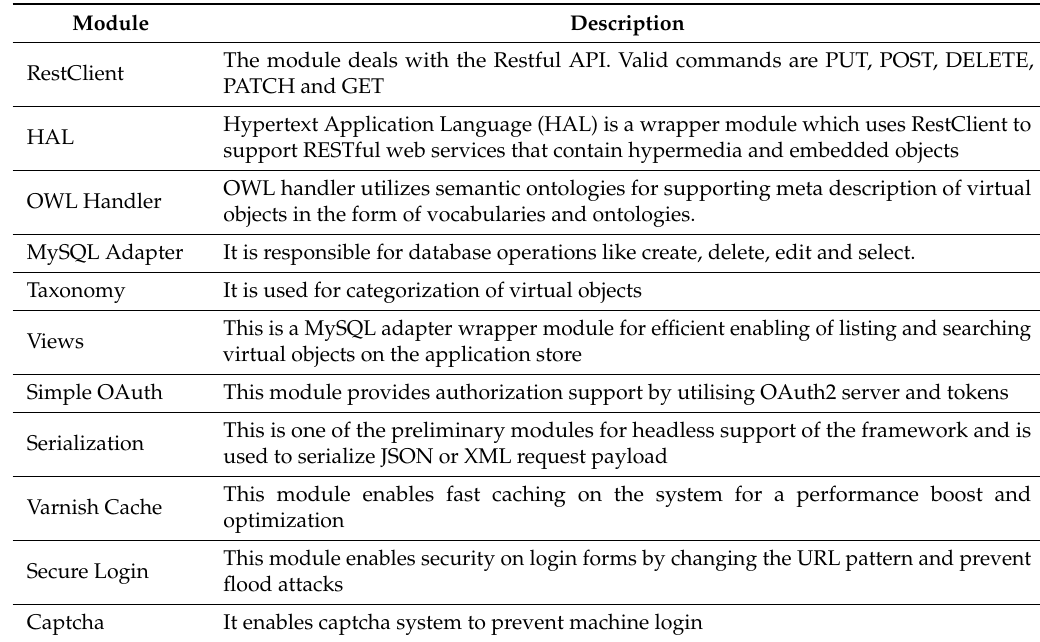
Table 2. Overview of different modules used in the proposed application